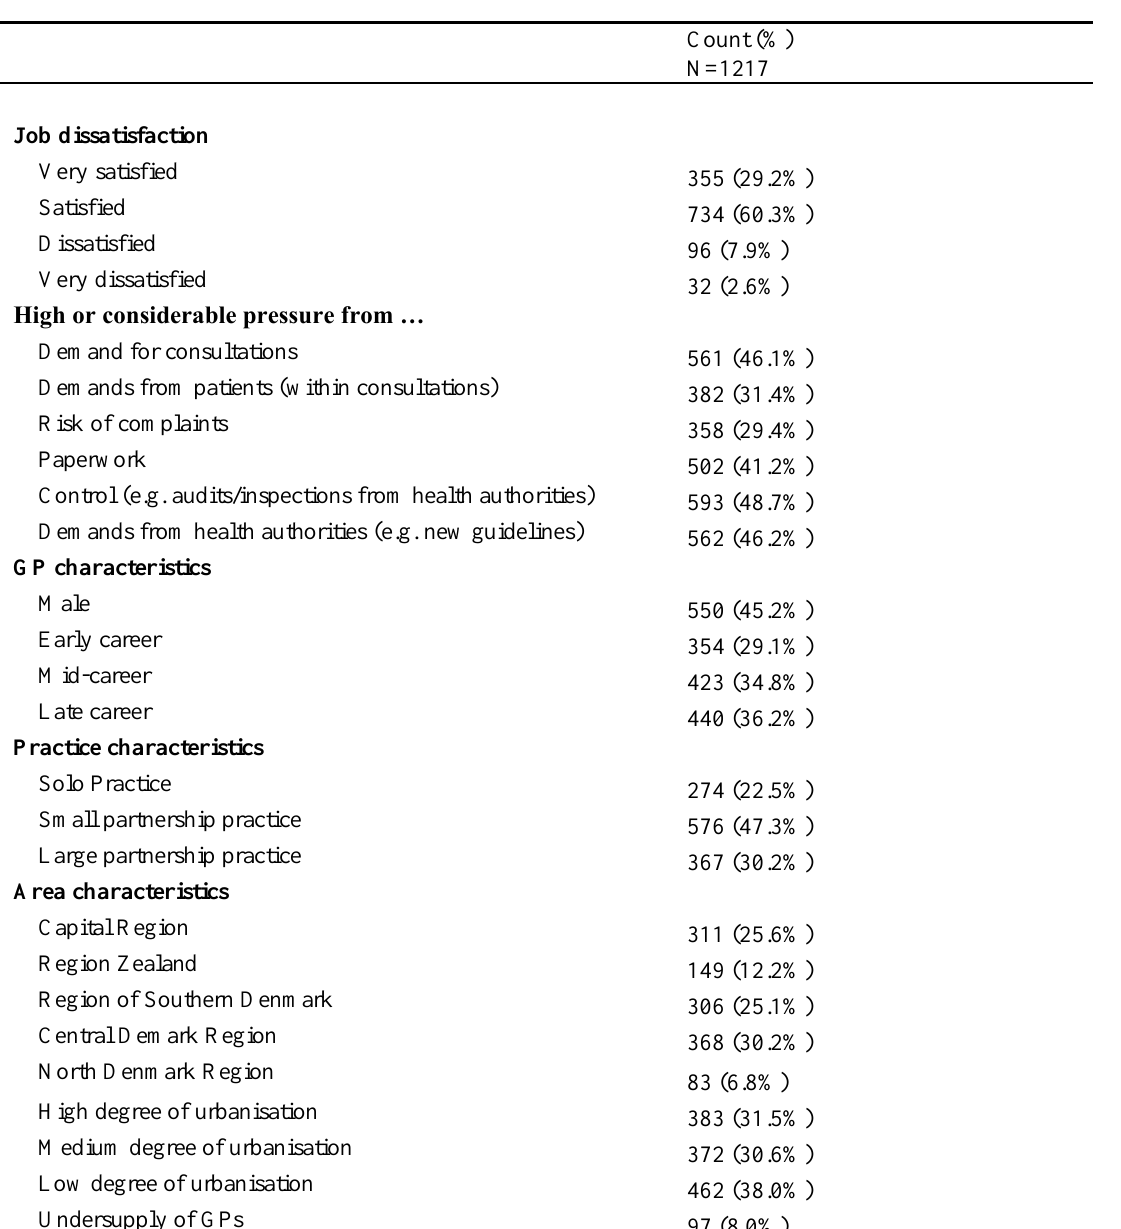
Descriptive statistics for survey